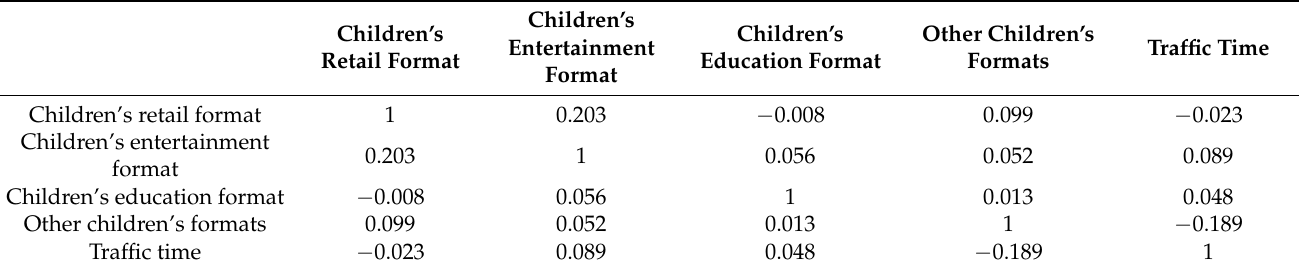
Table 2. Correlation matrix of explanatory variables.